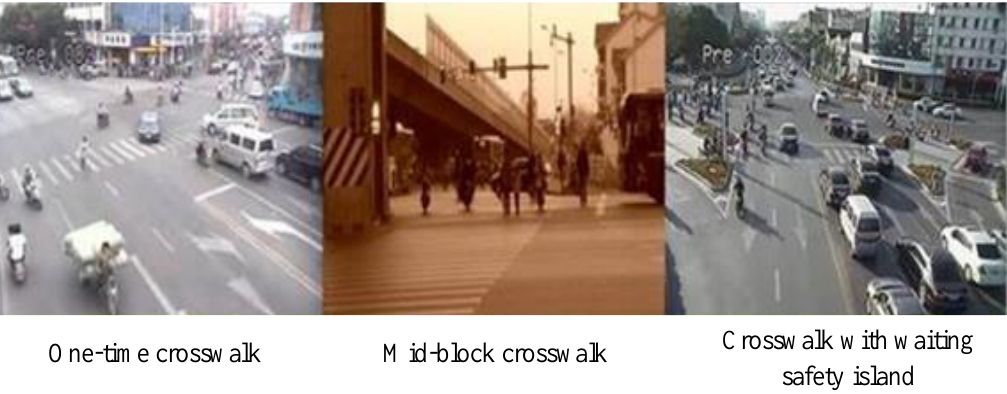
Figure 2. Three types of pedestrian crosswalk facilities at signal intersections.